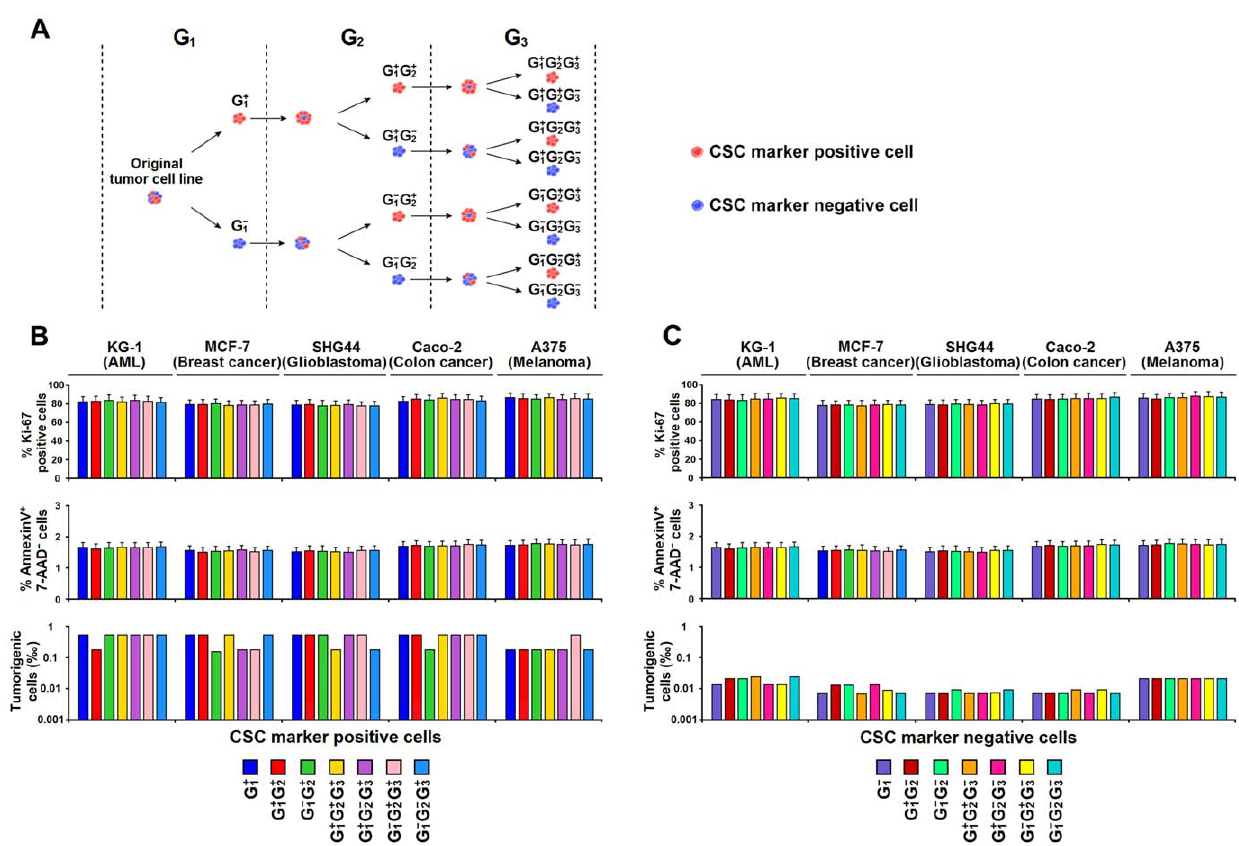
Figure 6. Proliferation and tumorigenesis of the CSC + (or CSC 2 ) cells from different generations are comparable. ( A ) Schematic diagram shows the cell classification based on generation and CSC marker expression. Cells from the original tumor cell lines were arbitrarily classified as generation 1 (G 1 ) cells and sorted into CSC marker positive (G 1 + ) and negative (G 1 2 ) cells. G 1 + and G 1 2 cells were then propagated (from 1 6 10 2 to approximately 1 6 10 8 ) to generate G 2 (including G 1 + G 2 + , G 1 + G 2 2 , G 1 2 G 2 + and G 1 2 G 2 2 ) cells. We repeated the procedure until G 3 cells were obtained. ( B and C ) CSC + and CSC 2 cells from different generations were used for proliferative and tumorigenic assays. Histograms show the percentage of Ki- 67 positive cells, the percentage of Annexin V + 7-AAD 2 cells, and the frequency of tumorigenic cells of CSC + cells ( B ) and CSC 2 cells ( C ) from different generations in KG-1, MCF7, SHG44, Caco-2 and A375. Frequency of tumorigenic cells was calculated using Extreme Limiting Dilution Analysis software. Other data are expressed as mean 6 SEM from 3 independent